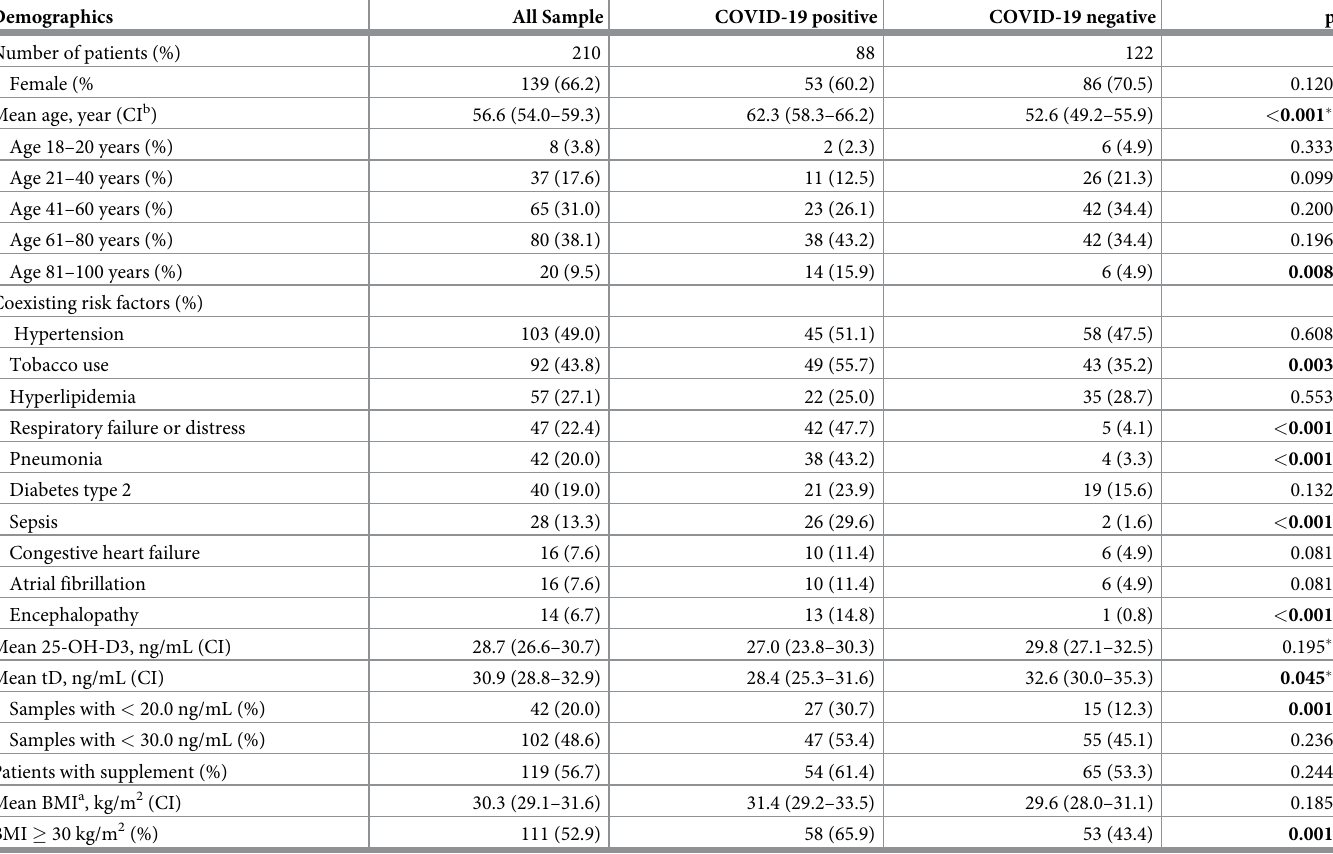
Table 2. The demographics of study